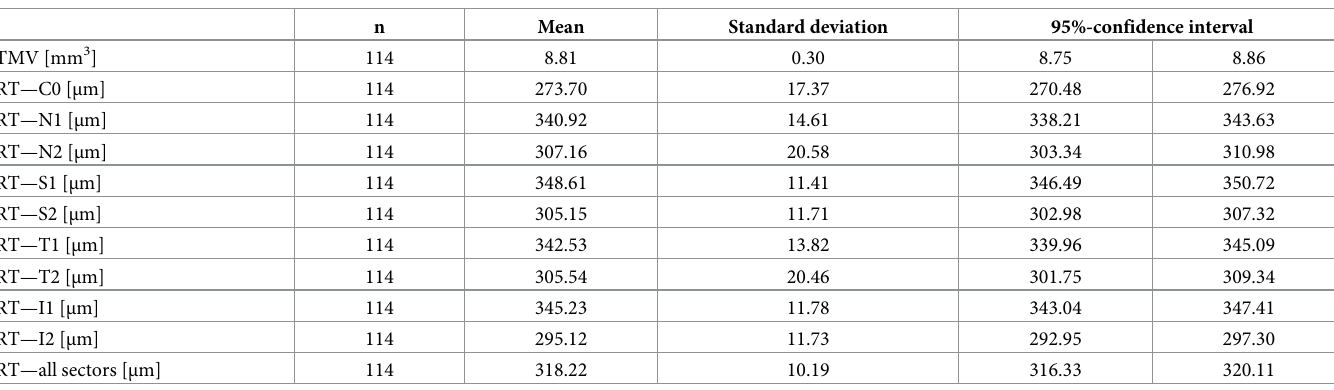
Table 5. TMV and RT analysis of macular scan